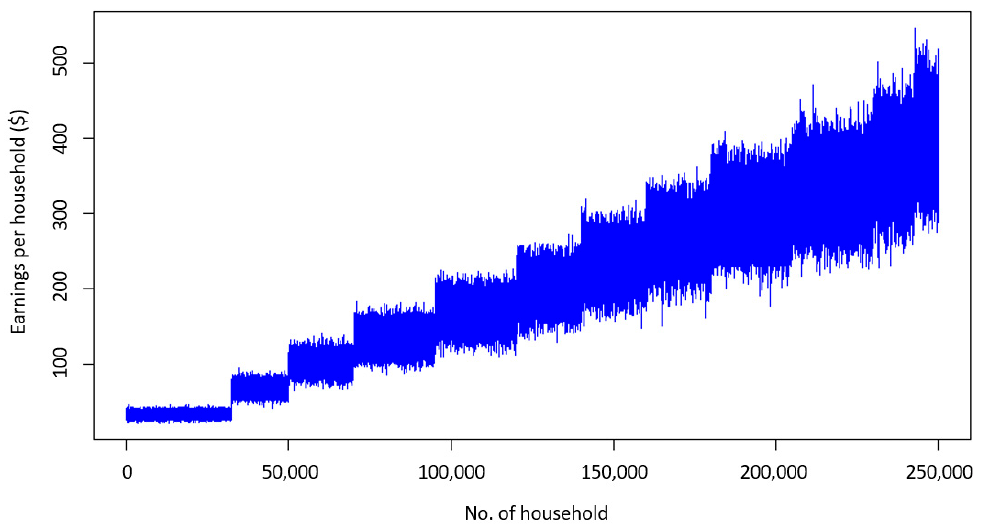
Figure 5. Monetary gain for each household. Sensors 2020 , 20 , x FOR PEER REVIEW